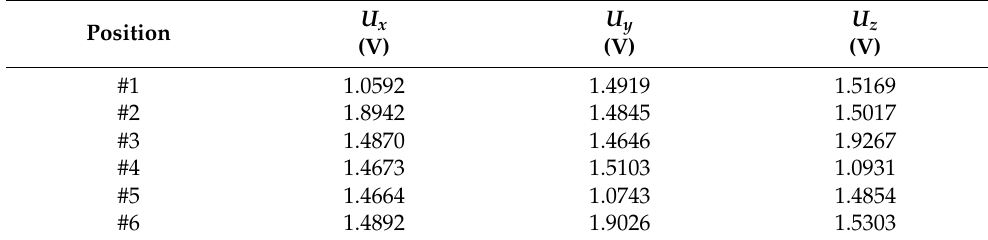
Table 2. Averaged values of the output voltages one hour after the start-up.